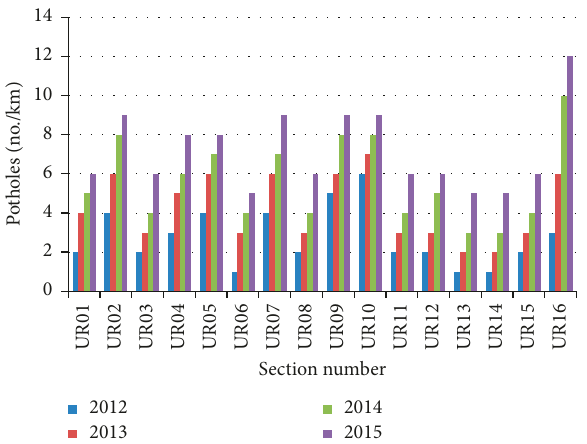
Figure 7: Progressive variation of potholes for the road sections UR01 to UR16.